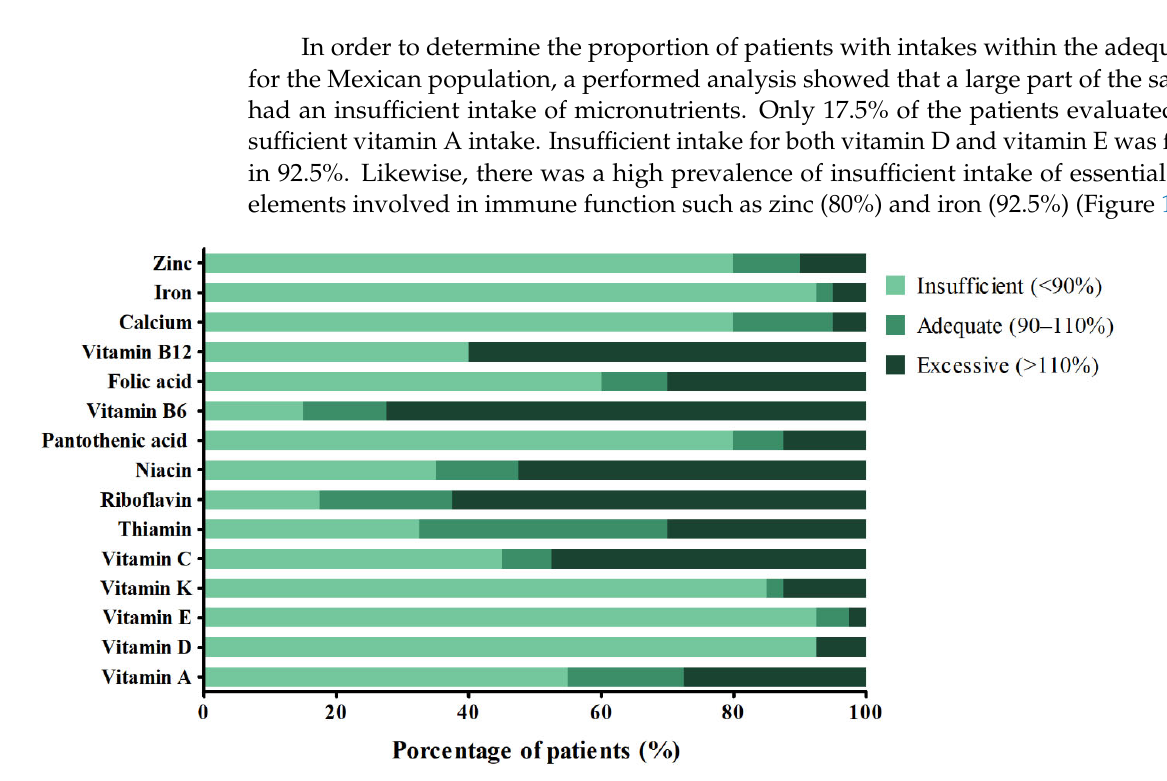
Table 3. Comparison between patients with 25(OH)D insufficiency and sufficiency.